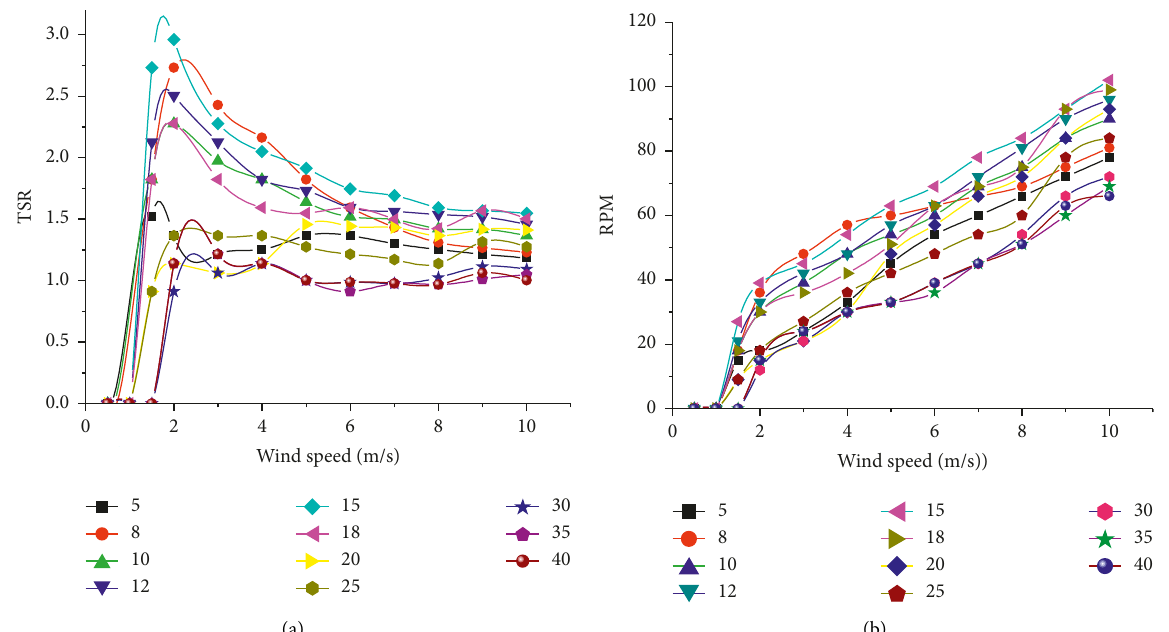
Figure 8: (a) RPM versus wind speeds for Styrofoam and (b) aluminium blades, respectively. 0.00.51.01.52.02.53.03.5 R T S